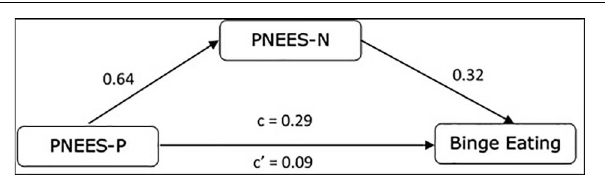
FIGURE 1 | Mediational analysis. All regression coefficients were significant at least at p < 0.05.